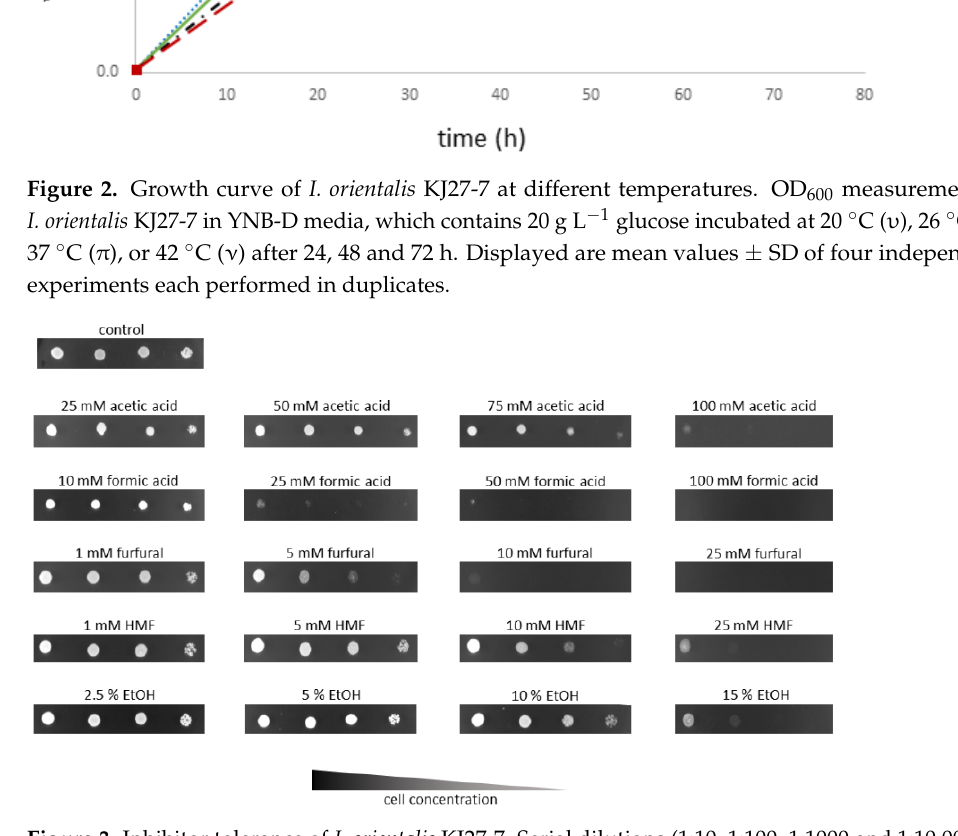
Figure 3. Inhibitor tolerance of I. orientalis KJ27-7. Serial dilutions (1:10, 1:100, 1:1000 and 1:10,000) of an I. orientalis KJ27-7 cell suspension (10 8 cells per ml) were spotted on YNB agar plates containing 20 g L −1 glucose and the indicated concentrations of either acetic acid, formic acid, furfural, HMF or ethanol (EtOH). Images are taken after 48 h incubation. One out of two representative experiments performed in quadruplicates are shown.